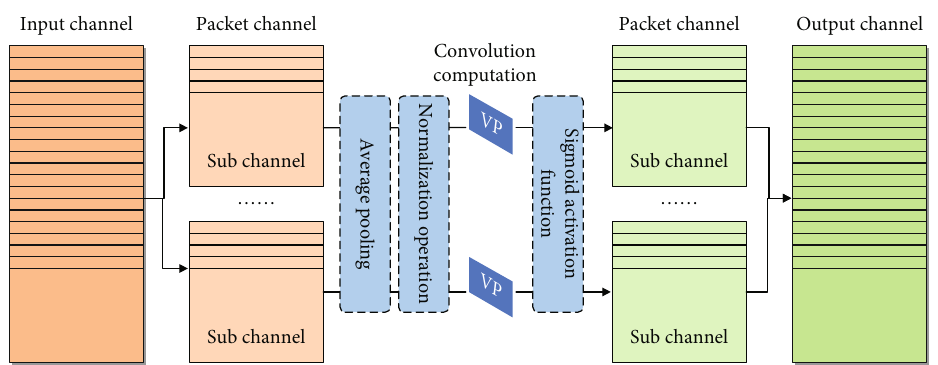
Figure 1: Structure of convolutional sparse self-coding neural network based on visual priority rule.